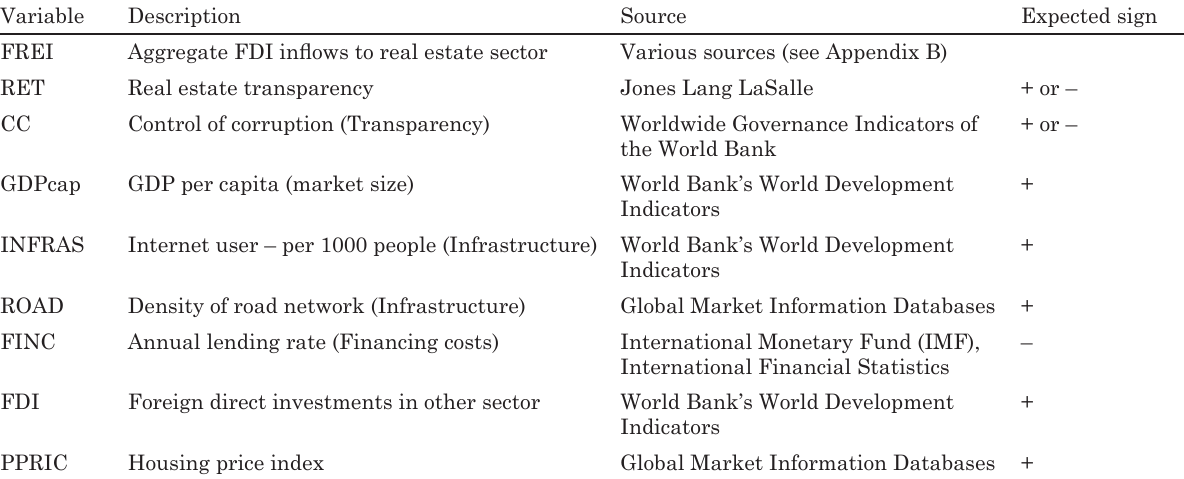
Table 2. Description of